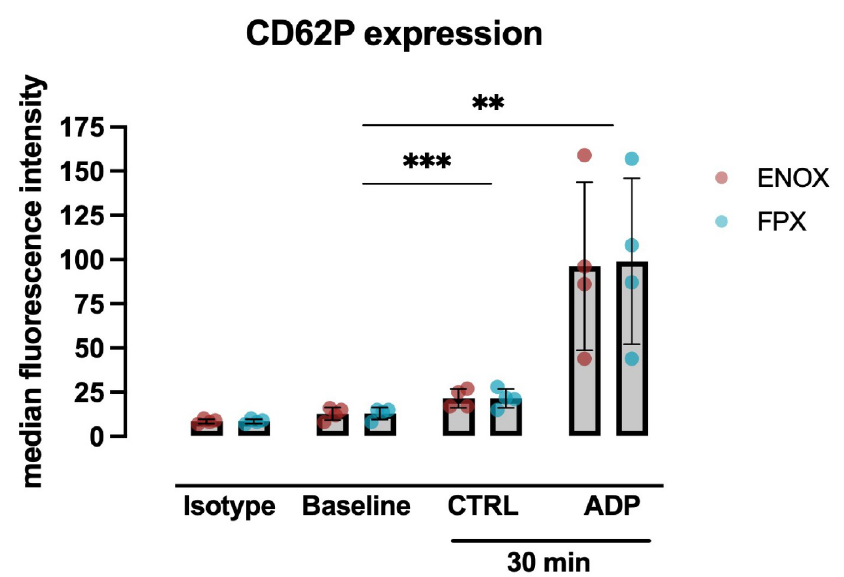
Fig 5. Platelet activation marker expression after ADP-stimulation. Flow-cytometric analysis of whole blood samples was performed using p-selectin (CD62P) as an activation marker on thrombocytes. Freshly drawn blood (Baseline) was compared with samples after 30 minutes of incubation (30 min) and after additional stimulation with ADP (ADP). Either enoxaparin (ENOX) or fondaparinux (FPX) was used as an anticoagulant in MPC-coated tubes. For statistical analysis, RM two-way ANOVA with Geisser-Greenhouse correction was performed using Tukey’s post- hoc testing (Isotype values were excluded from testing). �� p < 0.01; ��� p < 0.001. Values are presented as mean ± s.e.m. All samples: n =